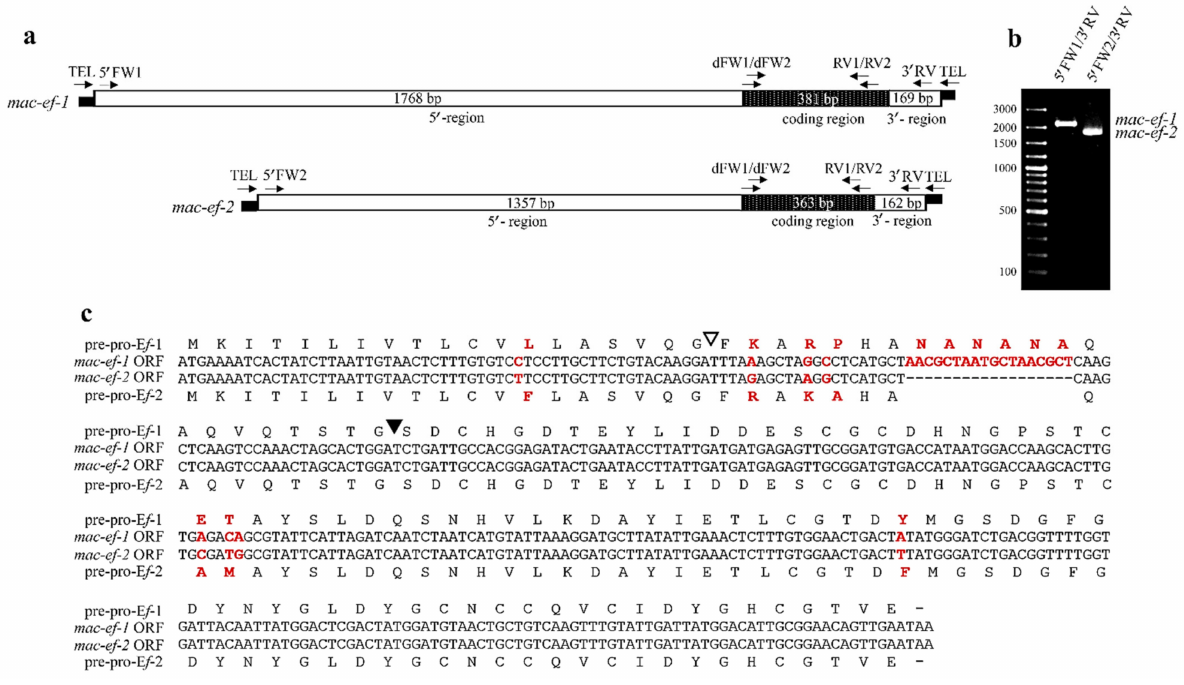
Figure 2. Structure of the mac-ef-1 and mac-ef-2 genes. ( a ) Schematic representations of the two genes, in which bars represent the telomeric ends consisting of C 4 A 4 and G 4 T 4 repetitions, boxes represent the 5 (cid:48) -leader, coding and 3 (cid:48) -trailer regions of different lengths, and arrows indicate the directions and positions along with the denominations of primers used in the PCR gene amplifications. ( b ) Agarose gel electrophoresis of PCR fragments obtained by amplifications of mac-ef-1 and